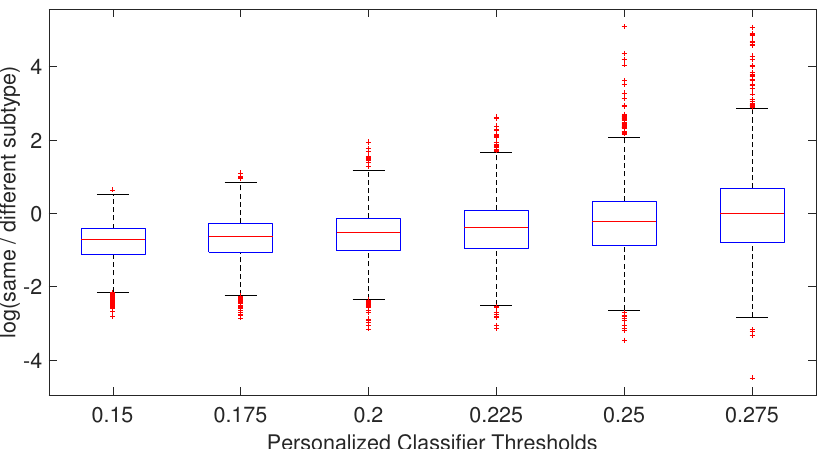
Figure 8. Boxplot of the ratio of patient subtype and other subtypes for each patient for each personalized classifier